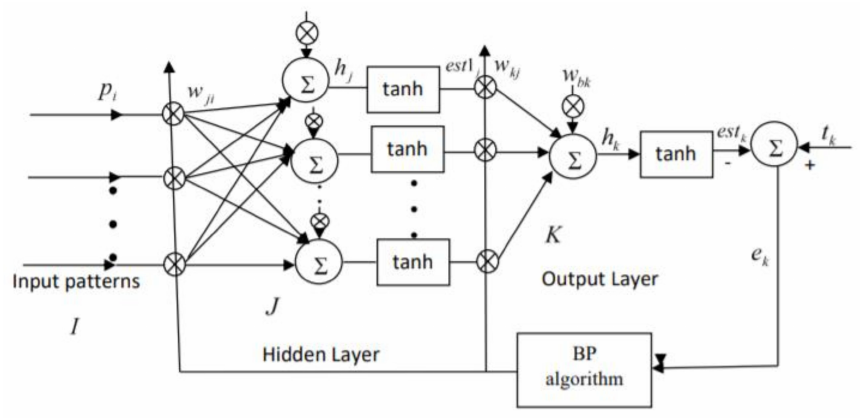
Figure 5. A MLANN based CO 2 emission prediction